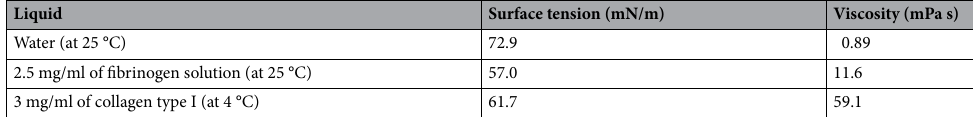
Table 1. Physical properties of liquids used in the experiments. Viscosities of hydrogel pre-solutions are measured at a shear rate of